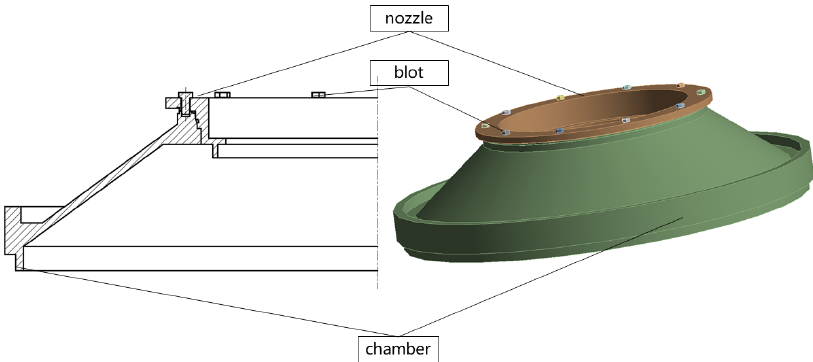
Figure 8. The simulation model of the space engine.